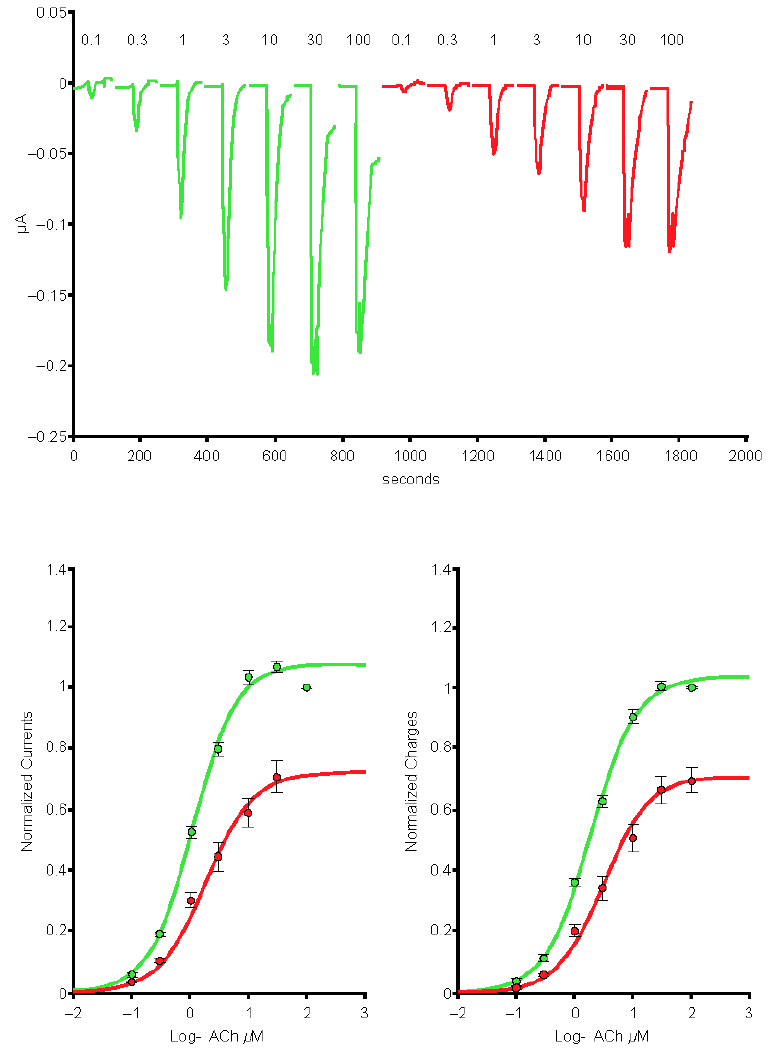
Figure 4. Effects of the SARS-CoV-2 spike protein S2 subunit at the human α 4 β 2 nicotinic acetylcholine receptor. Typical currents were recorded in the same cell before (green traces) and during exposure to 1 µg/mL of the Spike protein S2 subunit (red traces). Currents were elicited by brief exposure to acetylcholine (ACh) test pulses with a series of concentrations. Currents were normalized to unity vs. the maximal value and average results obtained in nine cells were plotted vs. the logarithm (log) of the ACh concentration. The green curve is the best fit obtained with the Hill equation. Areas under the curve are plotted on the lower right-hand side.